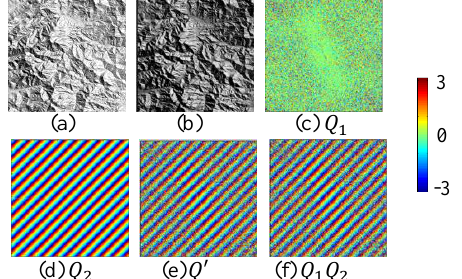
Figure 2. Impact of zenith angle variation on Phase